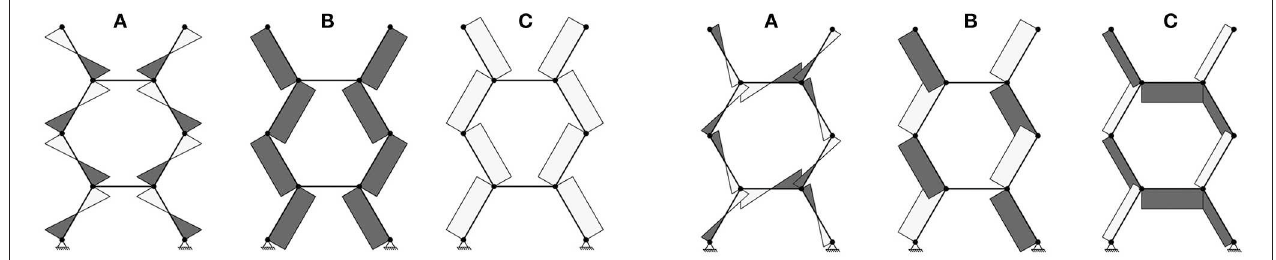
FIGURE 6 | Distribution of (A) bending moment, (B) shear and (C) axial forces under uniaxial compression (left) and under shear load